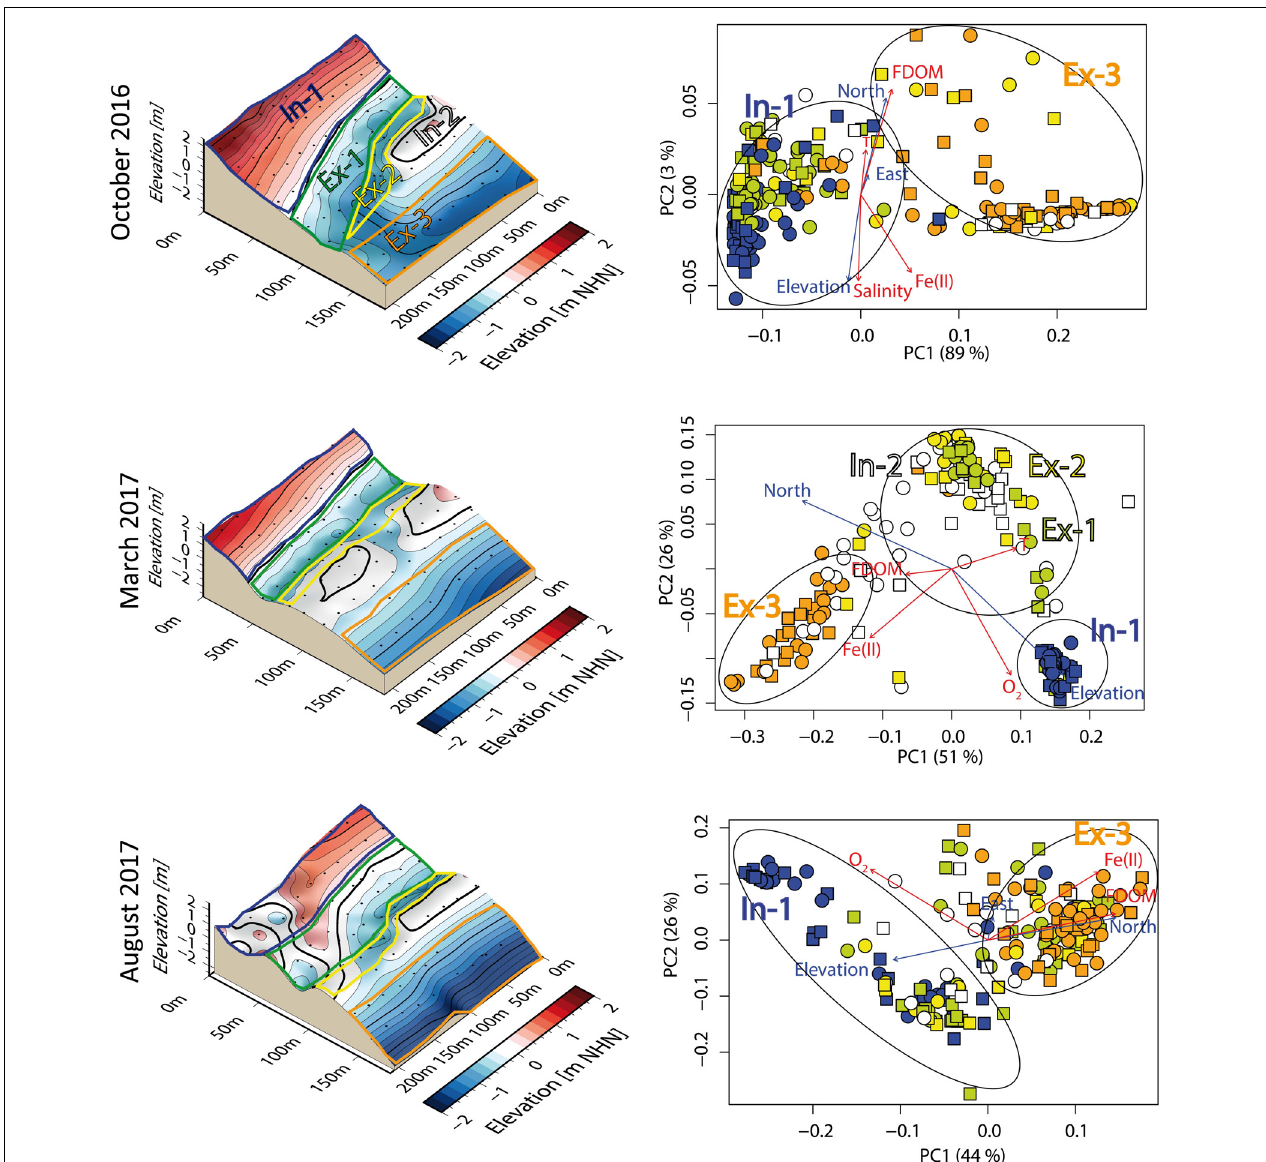
FIGURE 6 | Principal component analysis (PCoA) for the 3 sampling campaigns in October 2016, March, 2017, and August 2017. Right panel: Only topographic and physico-chemical parameters are displayed which have a significant influence ( p < 0.05) on the sample distribution in the PCoA. The ellipses in the PCoA demonstrate the clustering of different in- and exfiltration zones based on their physico-chemistry. The circles indicate data from 50 cm depth and the squares indicate data from 100 cm